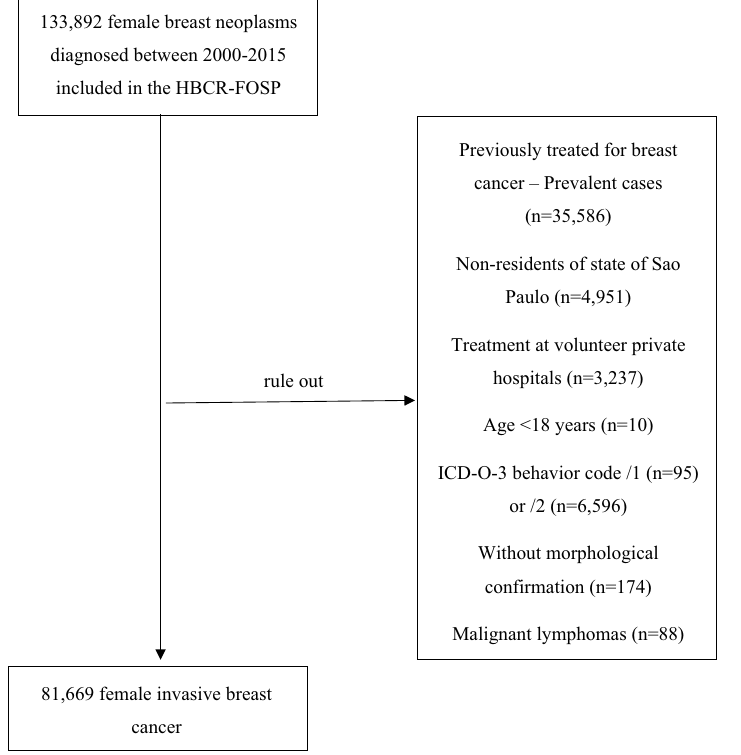
Figure 1. Flow diagram of inclusion criteria and exclusion